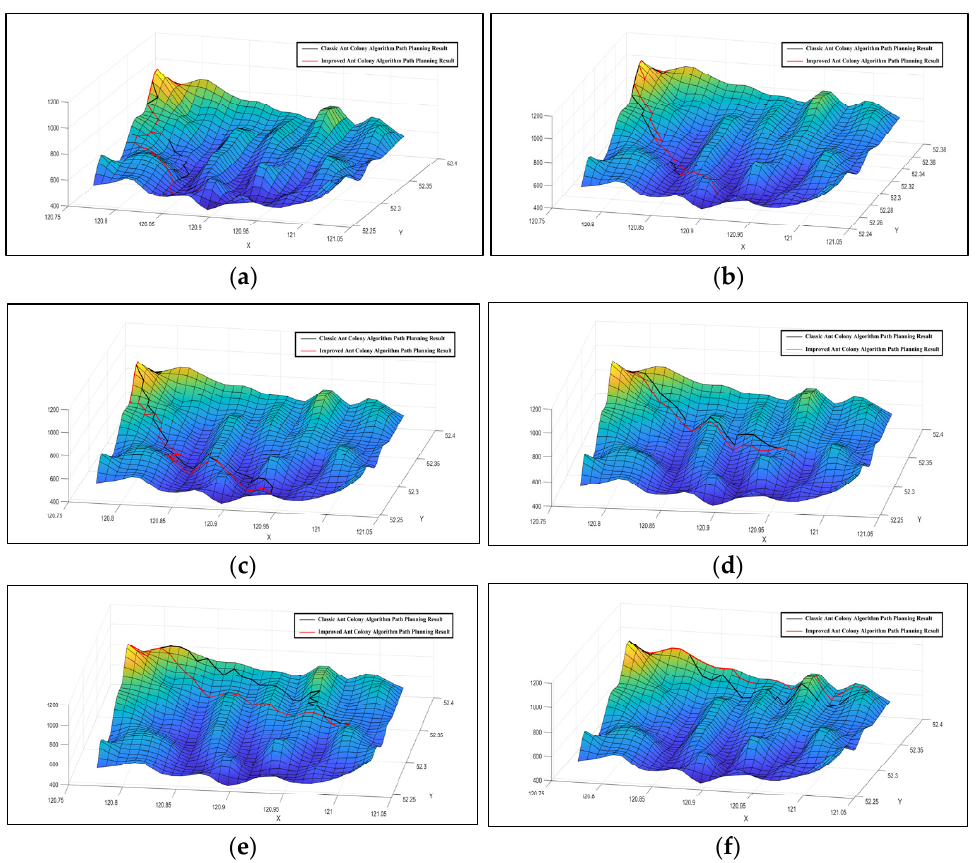
Figure 8. Three ‐ dimensional path contrast map before and after improvement .( a ) Comparison of Figure 8. Three-dimensional path contrast map before and after improvement. ( a ) Comparison the three ‐ dimensional path of point 1,( b ) Comparison of the three ‐ dimensional path of point 2, ( c ) of the three-dimensional path of point 1,( b ) Comparison of the three-dimensional path of point 2, Comparison of the three ‐ dimensional path of point 3, ( d ) Comparison of the three ‐ dimensional ( c ) Comparison of the three-dimensional path of point 3, ( d ) Comparison of the three-dimensional path of point 4, ( e ) Comparison of the three ‐ dimensional path of point 5 and ( f ) Comparison of the path of point 4, ( e ) Comparison of the three-dimensional path of point 5 and ( f ) Comparison of the three ‐ dimensional path of point 6. three-dimensional path of point